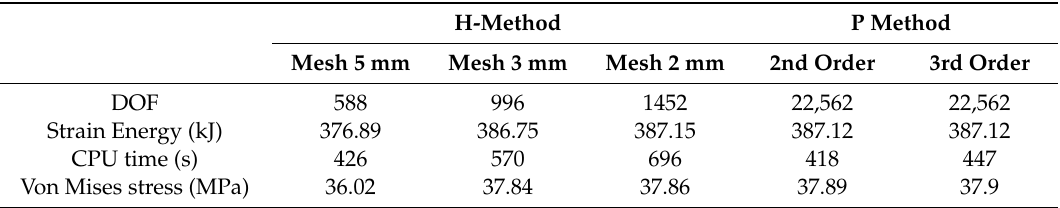
Figure 8. The indication of different numerical results in comparison with the analytical solution. Table 4. Comparison between two numerical approaches: H- and P- methods regarding the degree of freedom, strain energy and CPU time for cellular tubes while L / D =